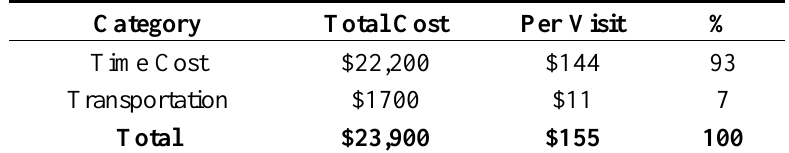
Table 8. Summary of cumulative labor cost and averaged cost per